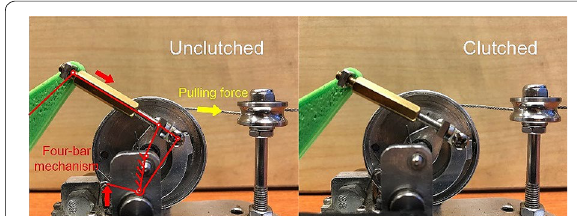
Figure 5 Clutched and unclutched states of the proposed clutch (it relies on the contact states between the rubber block and the flange of the pulley)